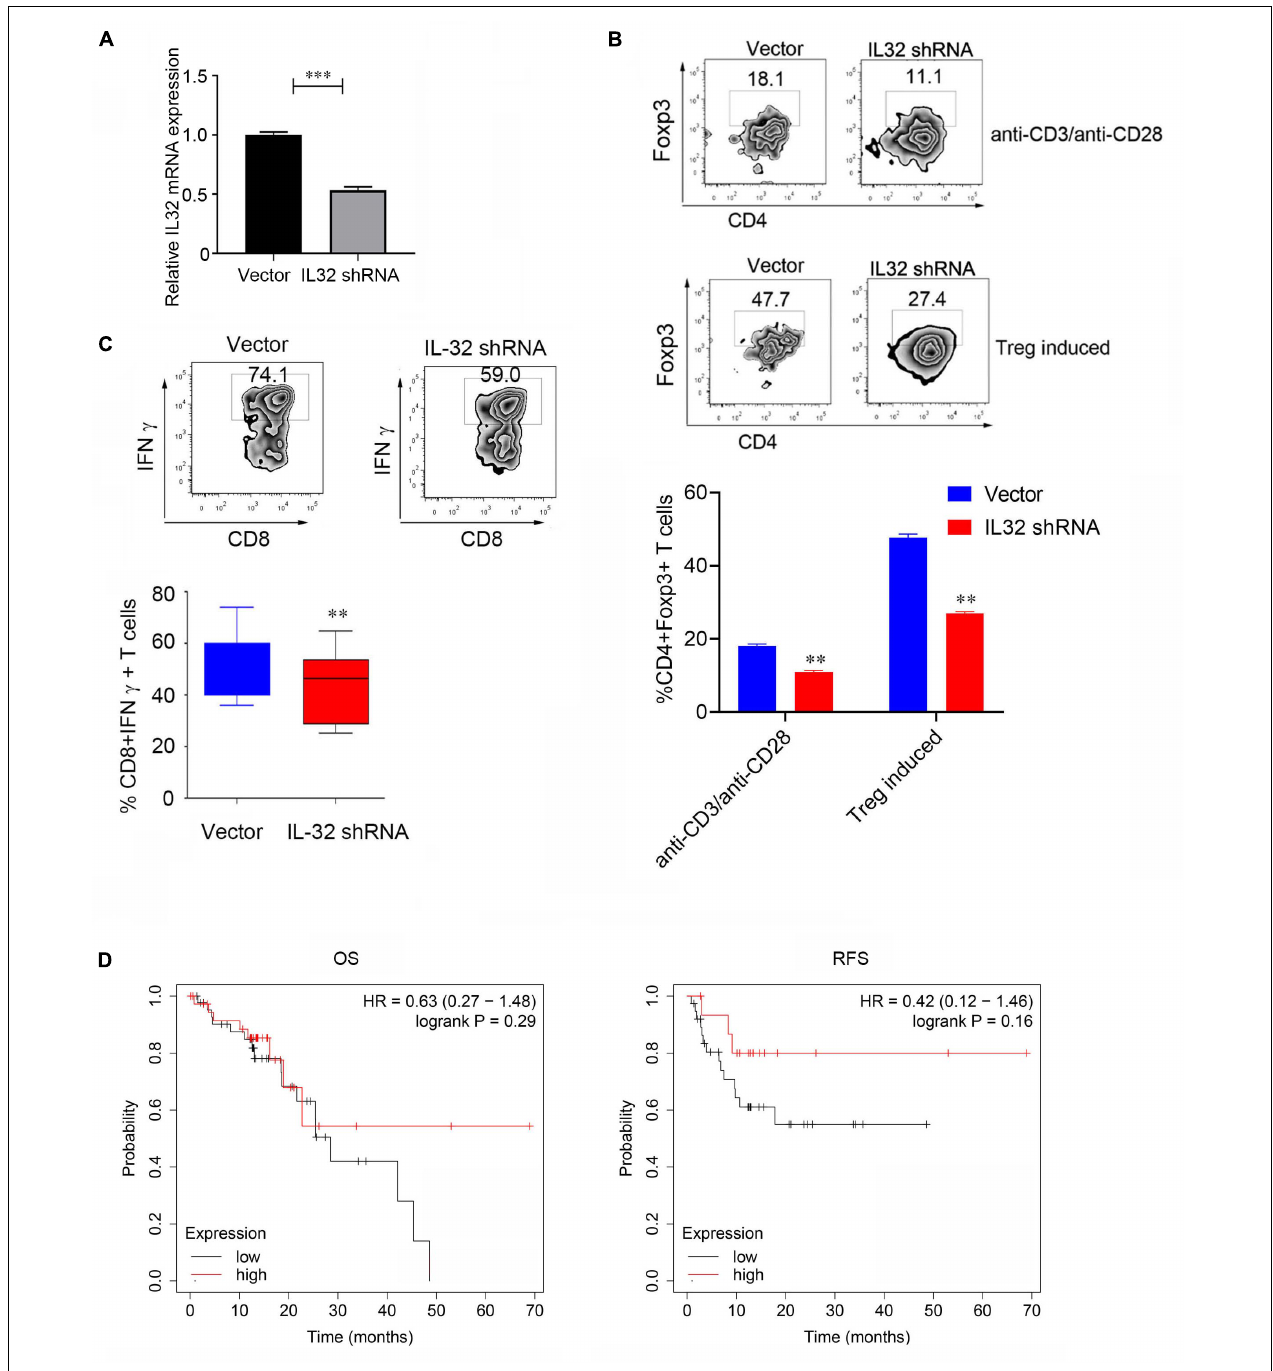
FIGURE 4 | Decreasing Foxp3 and IFN γ expression after IL-32 was knockdown. (A) The relative mRNA expression between control (vector) group and lentivirus transduction (IL-32 shRNA) group. p Value was calculated by two-tailed Student t test. (B) Proportions of CD4 + Foxp3 + Treg cells between the virus transfection with IL-32 shRNA and vector groups in CD4 + T cells isolated from PBMCs of healthy donors in vitro . The stimulation conditions were using the anti-CD3, anti-CD28 antibodies (top) activated CD4 + T cell and IL-2, transforming growth factor β induces Treg production (bottom). One of the three similar experiments is presented; data are presented as the mean ± SEM; p value was calculated by two-tailed Student t -test. (C) Flow cytometry measures the IFN γ expression in CD8 + T cells transfected with IL-32 shRNA and vector group. One of the three similar experiments is presented; data are presented as the mean ± SEM; p value was calculated by two-tailed Student t test. (D) Kaplan–Meier plot was used to analyze the overall survival ( left ) and disease-free survival ( right ) of IL-32 expression with the ESCC patients ( n = 81) from the TCGA data.